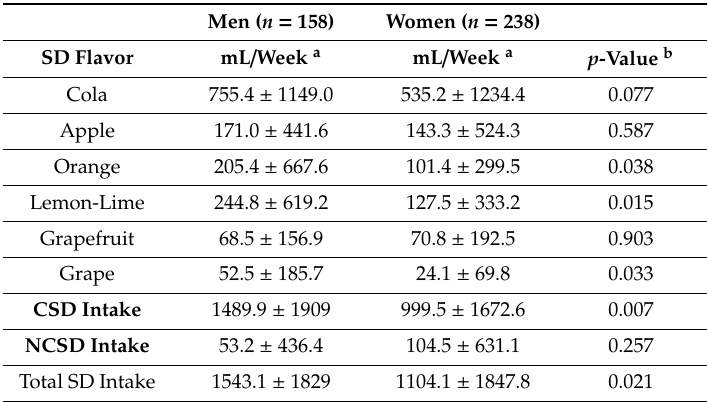
Table 1. Di ff erence in flavor preferences for caloric soft drinks (CSDs) and non-caloric soft drinks (NCSDs) according to